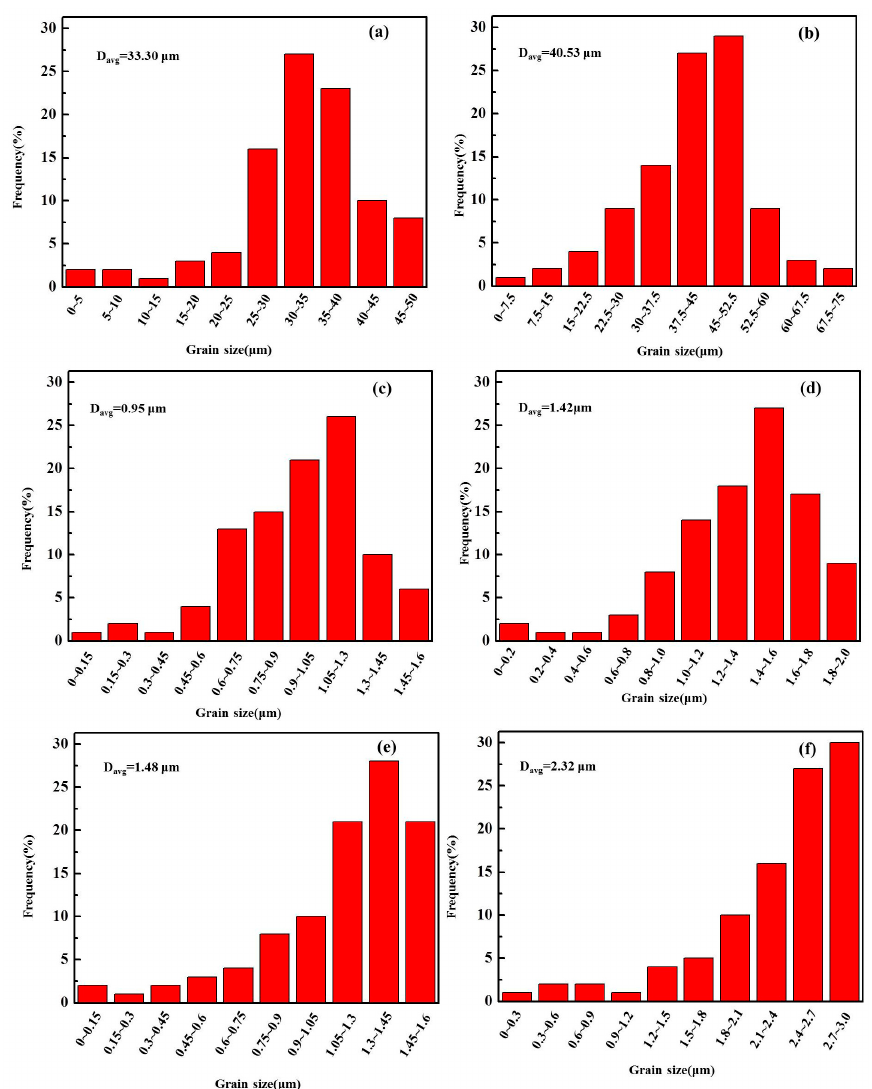
Figure 6. Grain size frequencies of different regions. ( a ) CuNiCrSi-BM; ( b ) CuCrZr-BM; ( c ) CuNiCrSi- NZ under condition A5; ( d ) CuCrZr-NZ under condition A5; ( e ) CuNiCrSi-NZ under condition A7; ( f ) CuCrZr-NZ under condition A7. (D avg means the average diameter of grains)